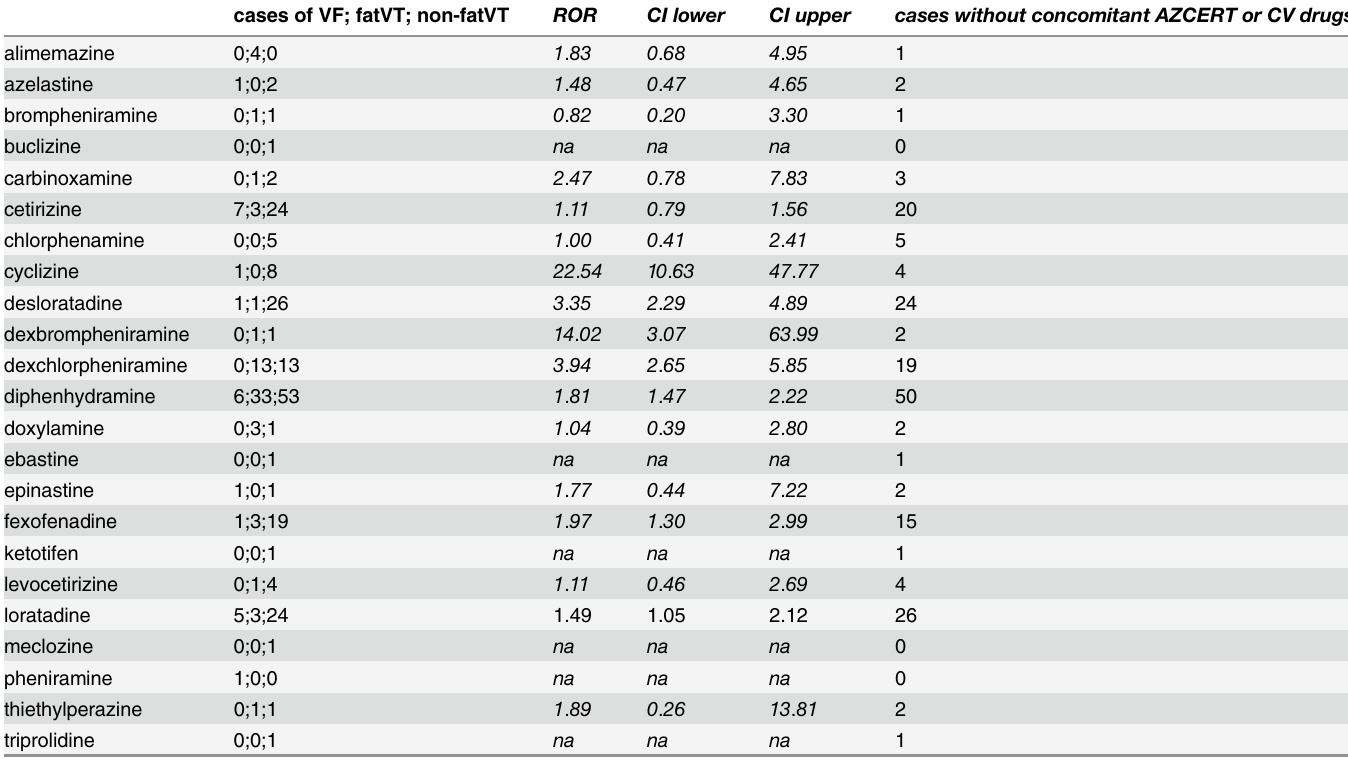
Table 2. Disproportionality analysis for antihistamines with cases of ventricular arrhythmia. cases of VF; fatVT;